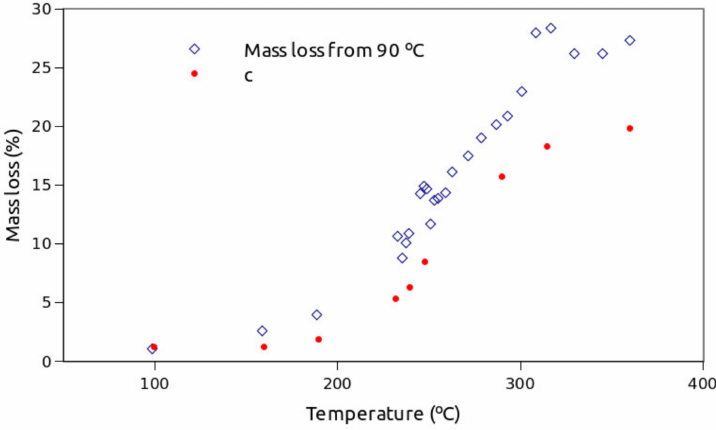
Figure 4. Plot of the mass loss obtained in isotherms versus the temperature of the isotherm.